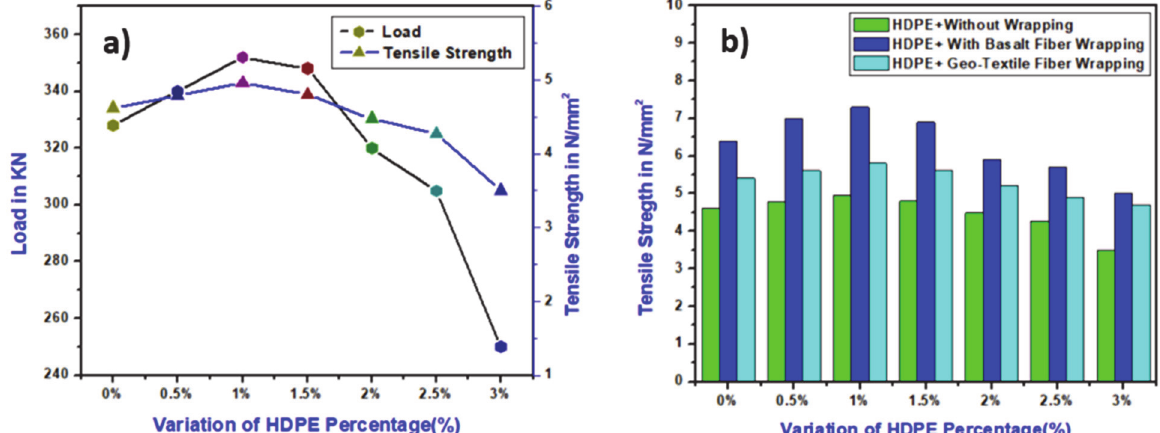
Figure 5: Tensile Strength of concrete samples (a) Tensile strength versus HDPE proportion (b) Tensile strength of fiber-wrapped samples versus HDPE proportion.